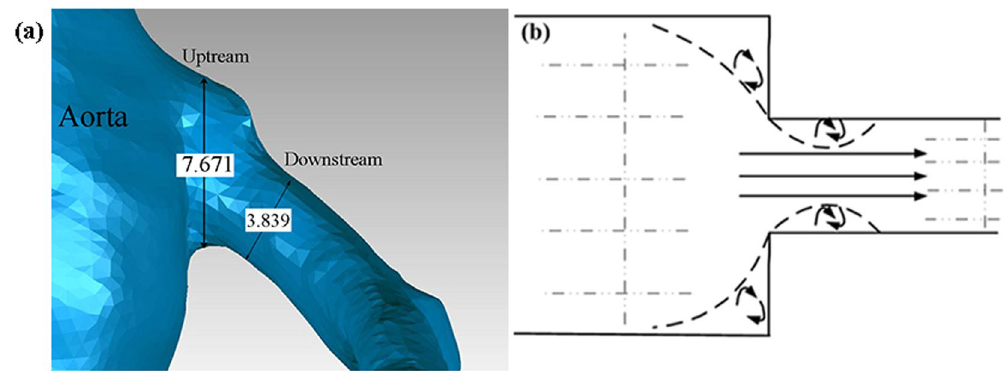
Figure 8. Locations of head loss in both the right and left coronary trees and the head loss due to a cross- sectional area